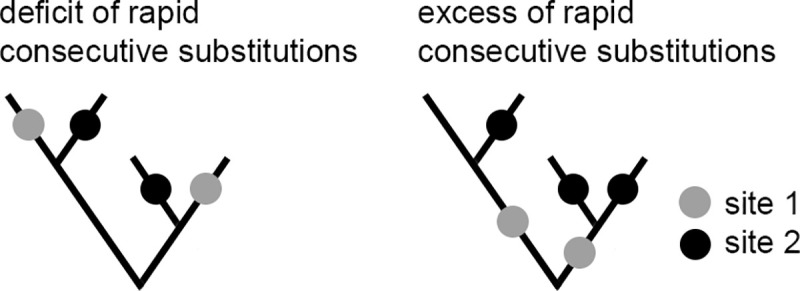
Phylogenetic approach for detection of concordantly and discordantly evolving site pairs.The approach is based on counting the rapid consecutive substitutions at site pairs. Two substitutions at sites 1 (gray dots) and 2 (black dots) are consecutive if they occur in the same line of descent (i.e., one is ancestral to the other) and no other substitutions at these sites occurred over the time period between them. A deficit of rapid consecutive substitutions implies discordant evolution of these two sites (here, 0 pairs of consecutive substitutions; left), while an excess of such substitutions implies their concordant evolution (here, 3 pairs of consecutive substitutions; right).